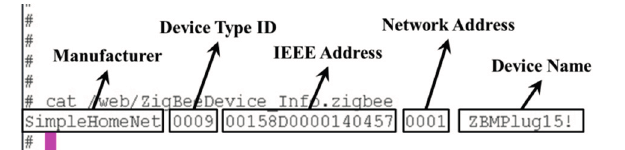
Figure 4. Management Information of ZigBee Device. The pink mark is the command input mark in the CLI (command line interface) mode of